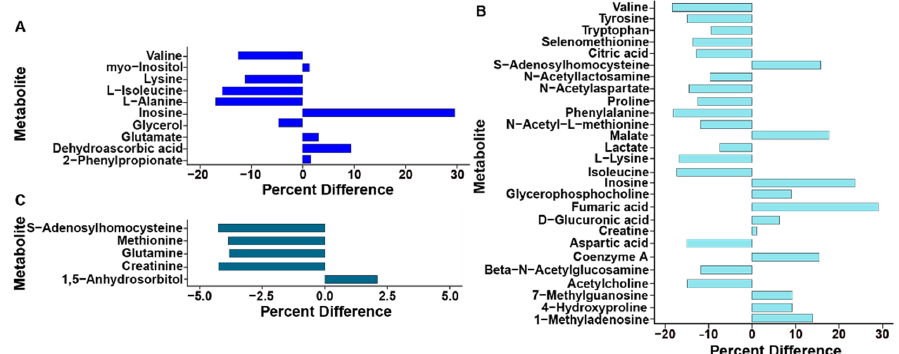
Figure 2. Percent difference for metabolites significantly altered in the control treatment when compared to the ethanol treatment. ( A ) Kidney. ( B ) Liver. ( C ) Breast muscle. All metabolites were significantly altered based on paired t -test and/or multivariate variable importance analysis based on random variable combination analysis.